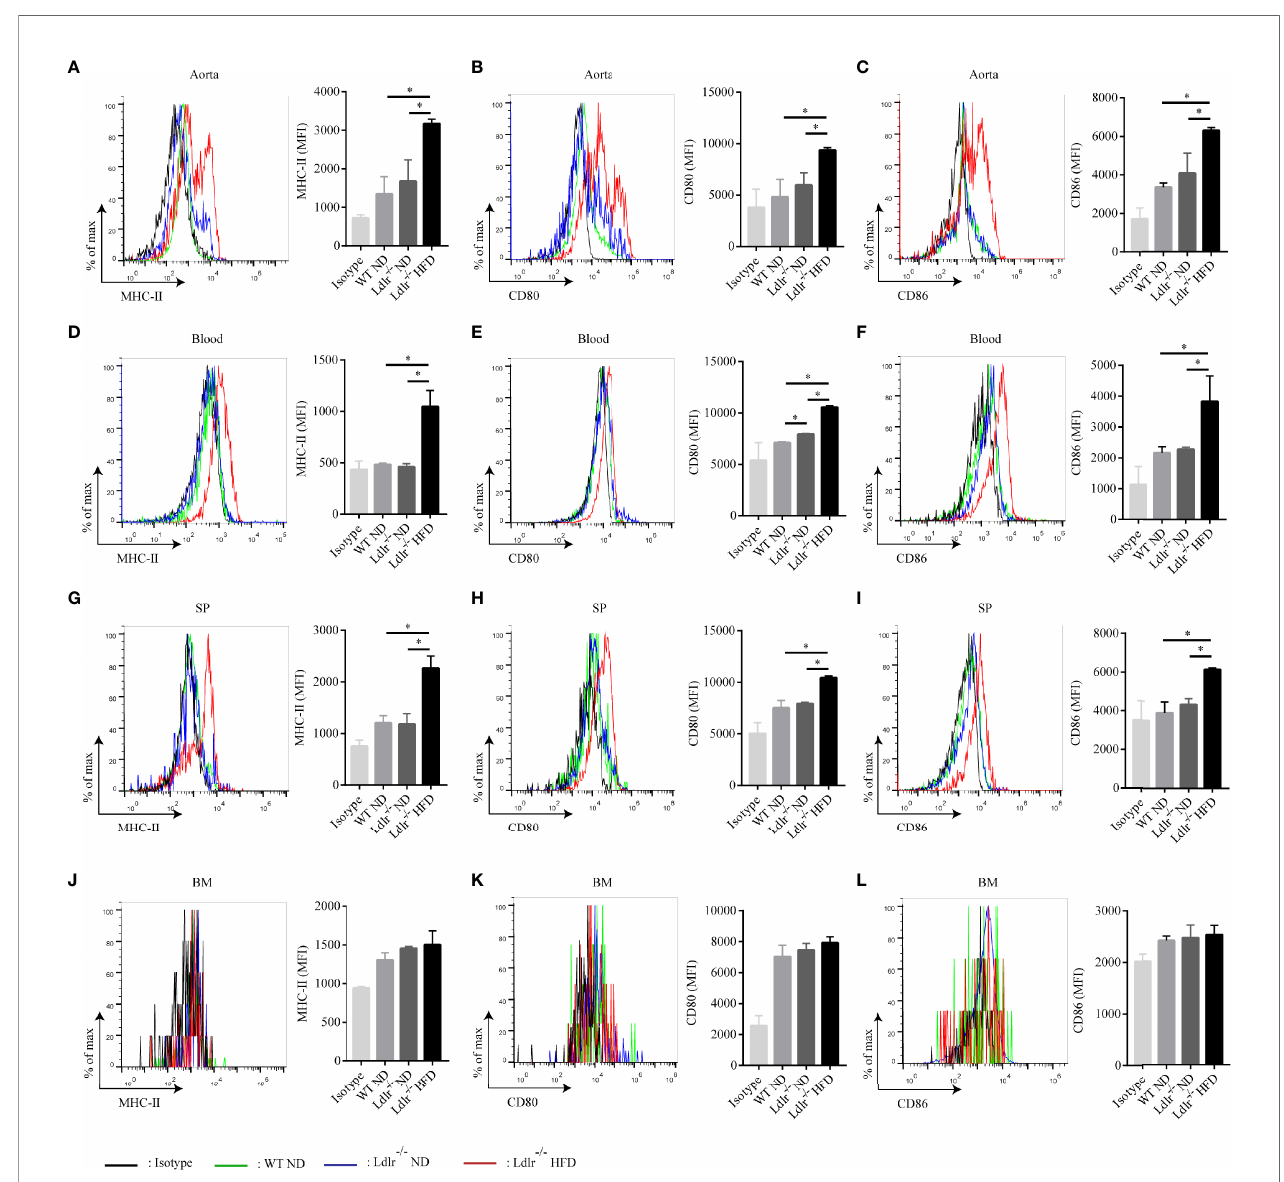
FIGURE 3 | Neutrophils with characteristics of APC are present in atherosclerotic mice. Expression of MHC-II, CD80, CD86 on neutrophils in the (A – C) aorta, (D – F) blood, (G – I) spleen (SP), and (J – L) bone marrow (BM) of WT ND (green line), LDLr -/- ND (blue line) and LDLr -/- HFD mice (red line) (n=8). Black line: isotype control. MFI, mean fl uorescence intensity. *p <